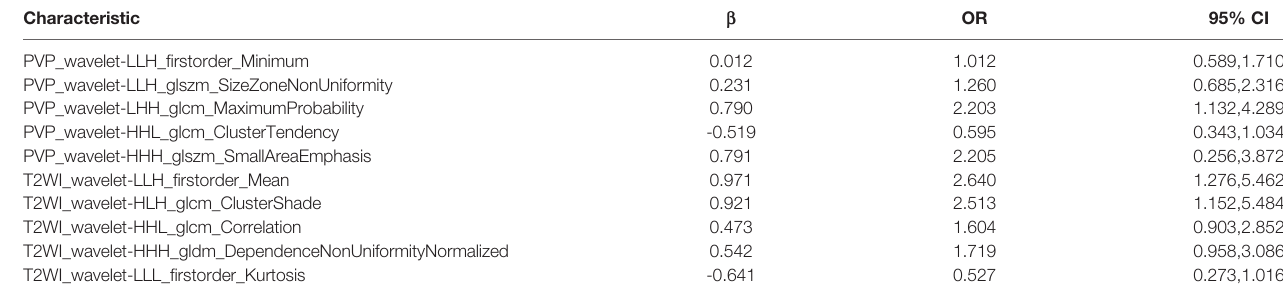
TABLE 2 | Radiomics features selected by GBDT.